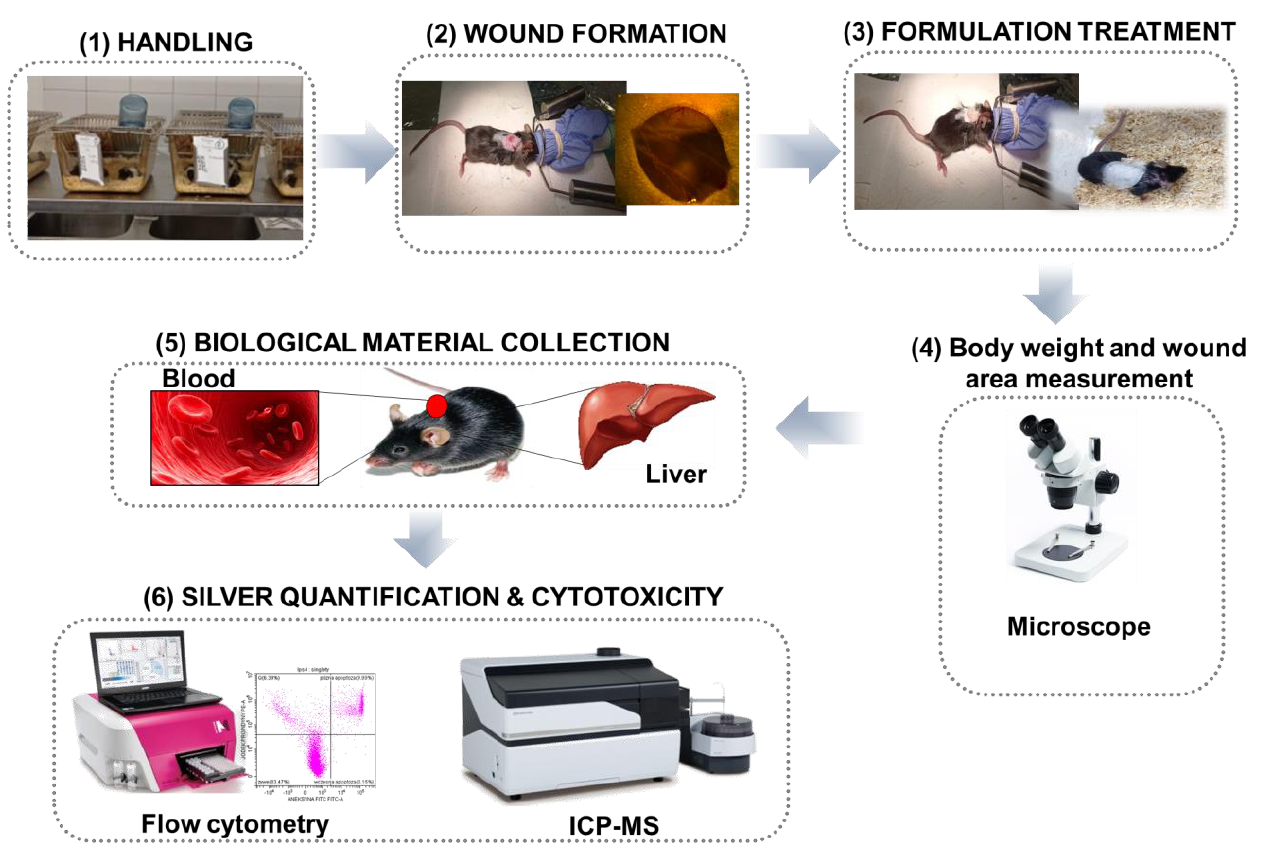
Figure 4. Design representation of the scheme protocol followed in the present research.